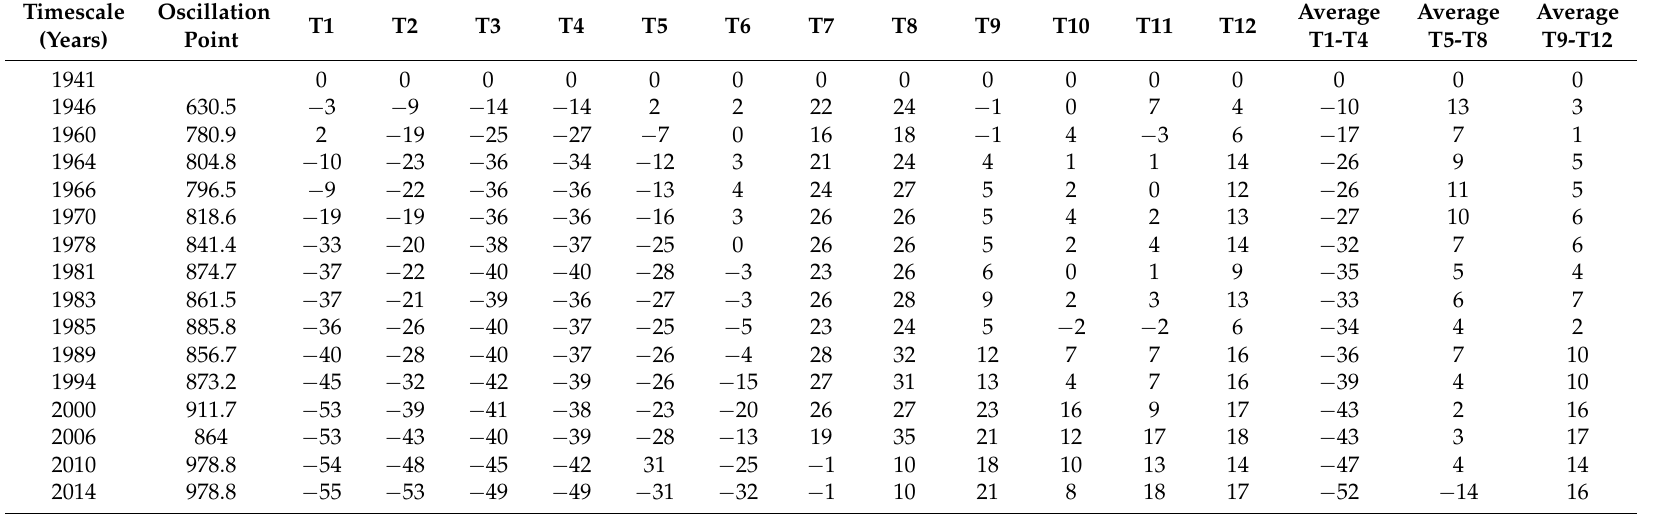
Table 2. Shoreline position by transect, in relation to the 1941 baseline (Note: negative values depict shoreline retreat, positive values depict shoreline advance and all values are in